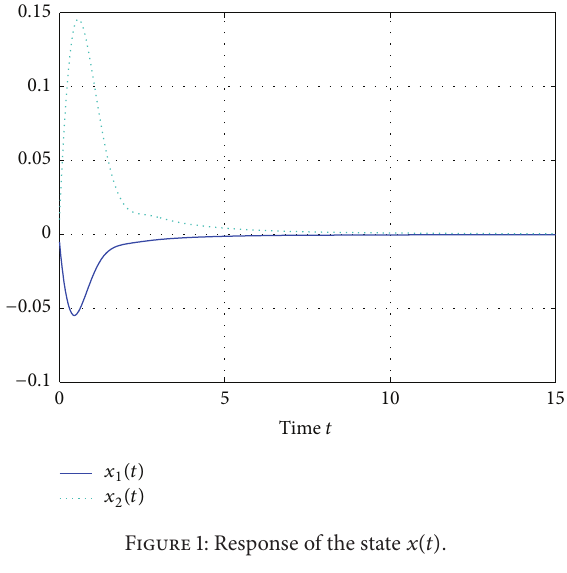
Figure 1: Response of the state 𝑥(𝑡) .